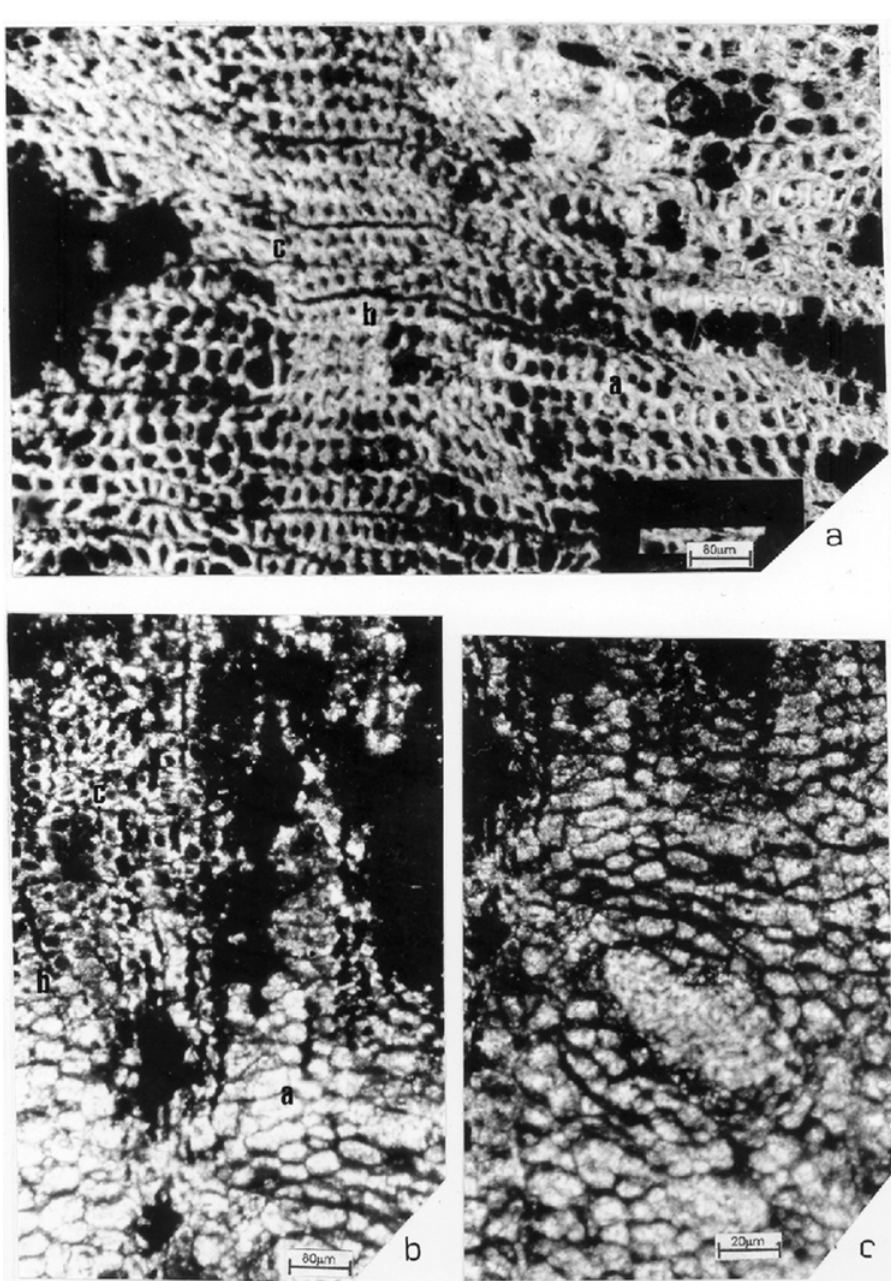
Fig. 4 – Sommerxylon spiralosus n.gen. et n.sp. Transverse section – a: secondary xylem showing the limit of growth ring; a – early wood; b – late wood; c – limit of the ring. b: limit among tissues; a – cortex; b – limit among issues; c – phloem with parenchymatous cells (clear with dark contents) and phloematic rays (dark radial bands). c: cortex with circular cells and